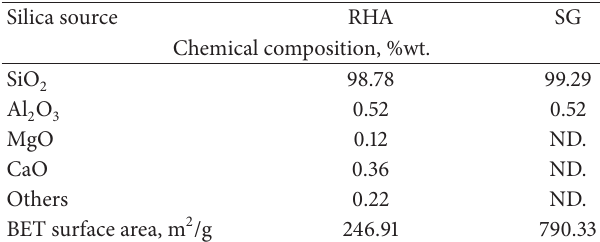
Table 1: The chemical compositions and BET surface areas of silica sources.